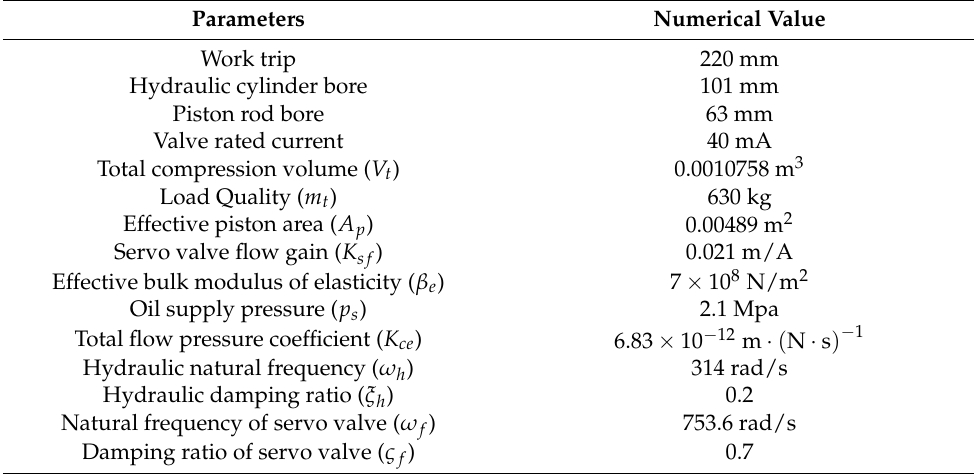
Table 1. Hydraulic cylinder and servo valve